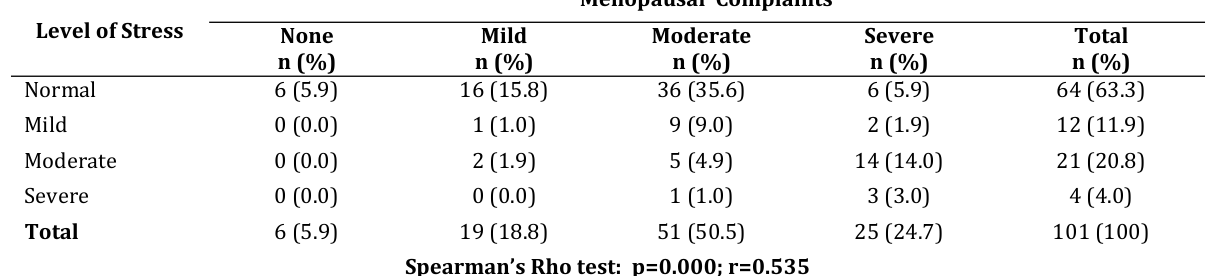
Table 4. Level of Stress to Menopausal Complaints (n=101) Level of